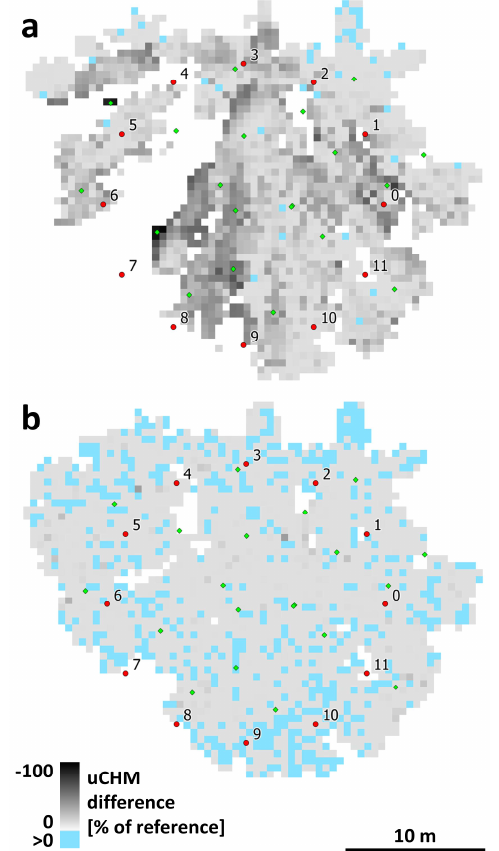
Figure 7: Exemplary uCHM difference values. (a) uCHM derived from point cloud simulated for SP03, (b) all scan positions combined. Grey scale: uCHM underestimations from 100% of reference to 0% of reference, blue cells: uCHM